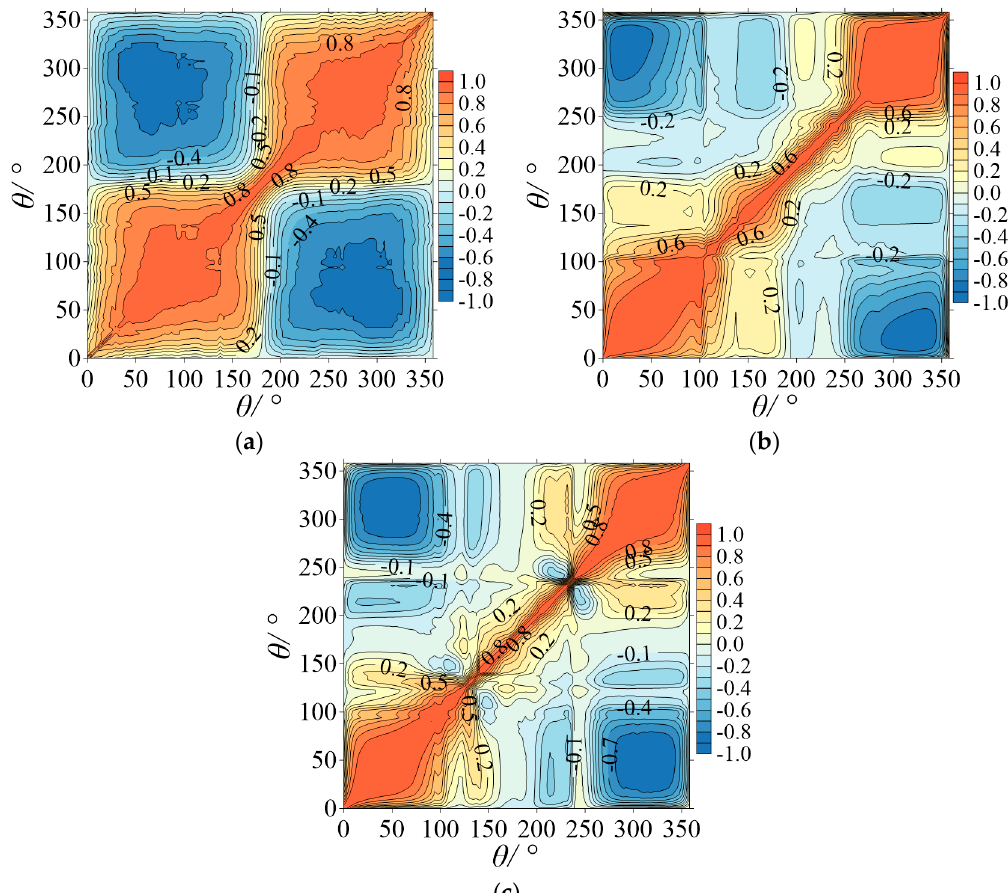
Figure 22. Correlation coe ffi cients of wind pressure at di ff erent wind speeds. ( a ) Re = 1.04 × 10 5 ; Figure 22 . Correlation coefficients of wind pressure at different wind speeds. ( a ) Re = 1.04 × 10 5 ; ( b ) Re ( b ) Re = 3.52 × 10 5 ; ( c ) Re = 7.25 × 10 5 = 3.52 × 10 5 ; ( c ) Re = 7.25 × 10 5 .